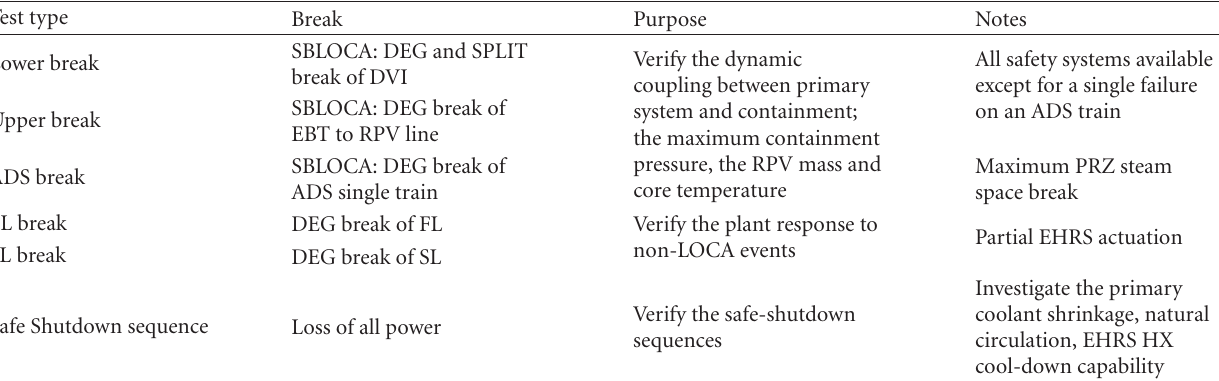
Table 2: SPES3 Test matrix summary and main goals.